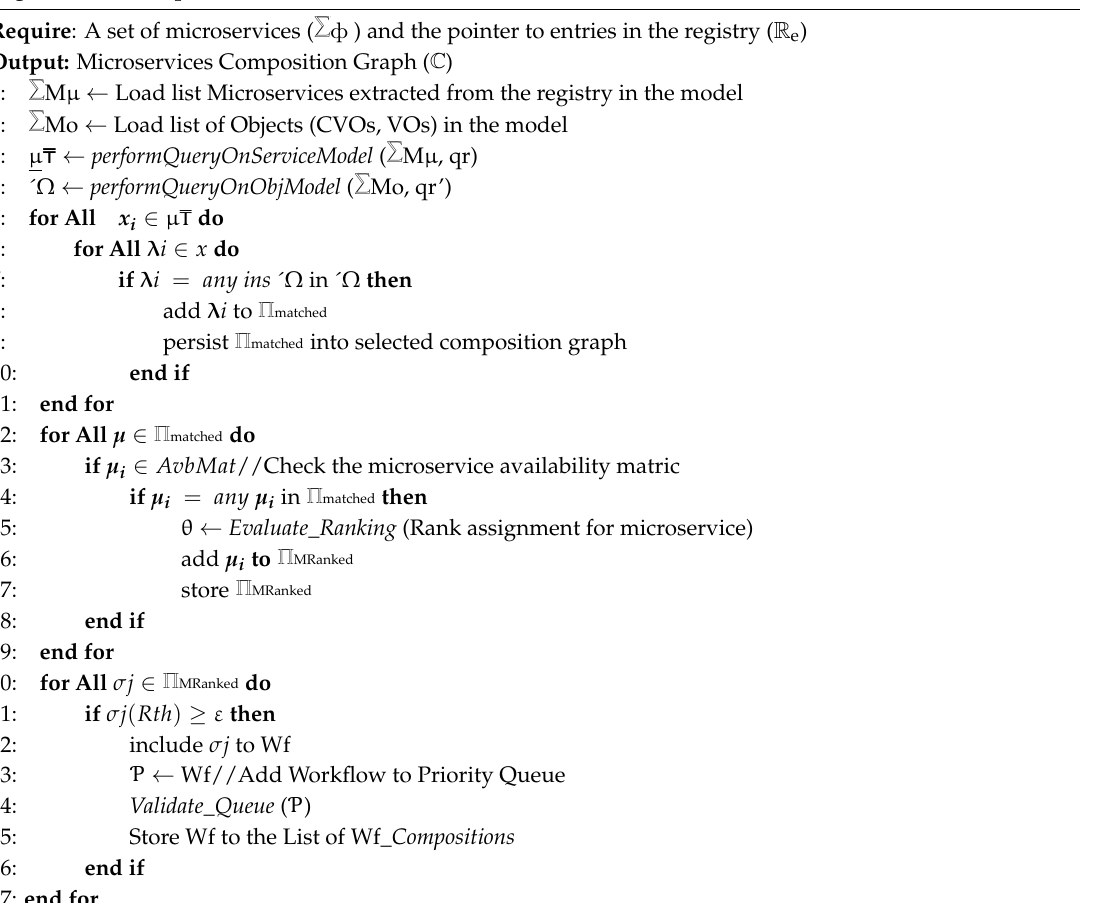
Table 2. Notations used in the algorithm. Algorithm 1: Composition of Microservices